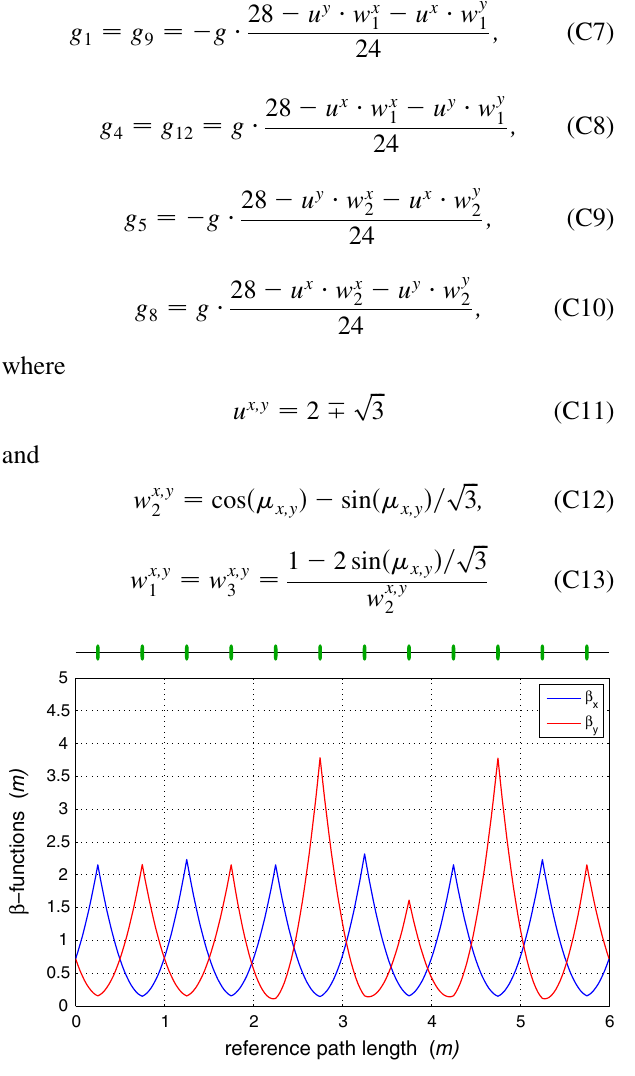
FIG. 4. Betatron functions along the phase advance scan beam ¼ 0 (cid:8) , (cid:8) ¼ (cid:4) 40 (cid:8) line for (cid:8) x y